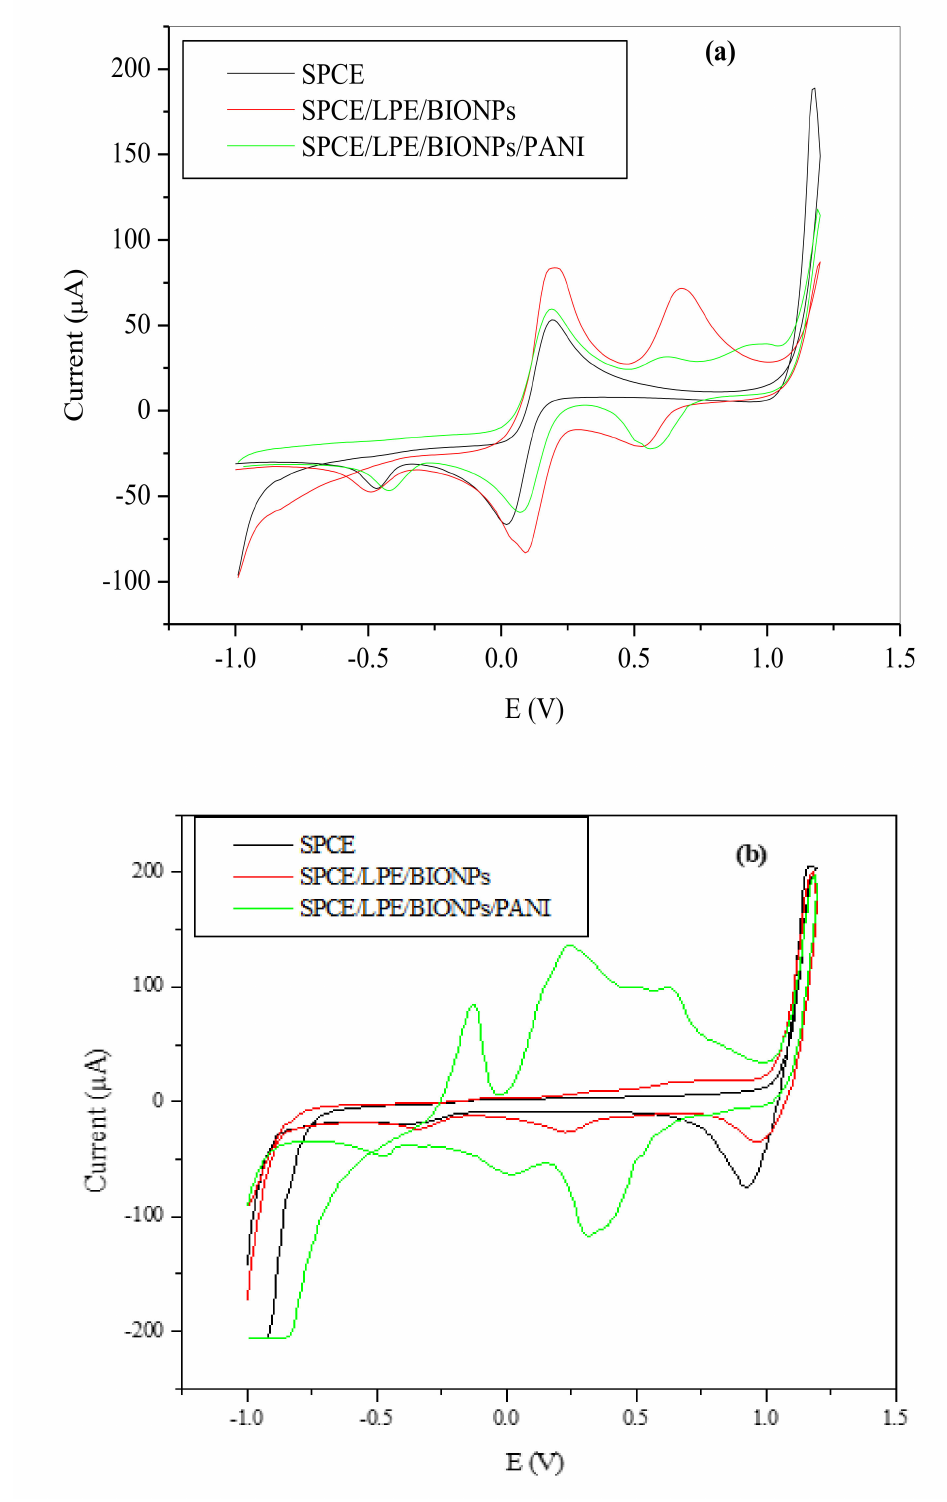
Figure 6. The comparative voltammogram of the SPCE, SPCE/LPE/BiONPs and SPCE/LPE/ BiONPs/PANI in ( a ) 0.1 M HCl (scan rate = 0.1 V/s) and ( b ) probe (scan rate = 0.01 V/s). Potentials vs.